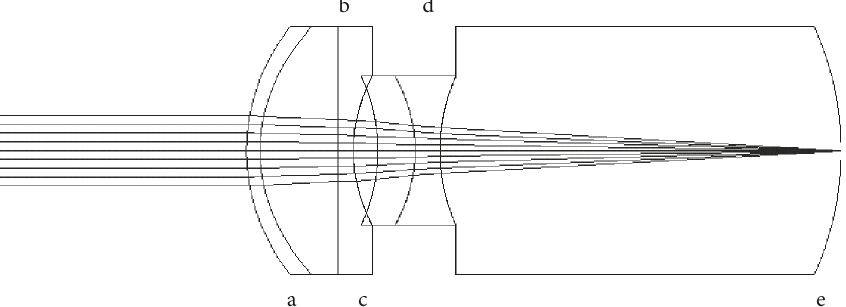
Figure 2: Liou-Brennan eye model with intraocular telescope ITS 2. a, cornea; b, pupil; c, anterior positive lens; d, posterior positive lens; e, retina.